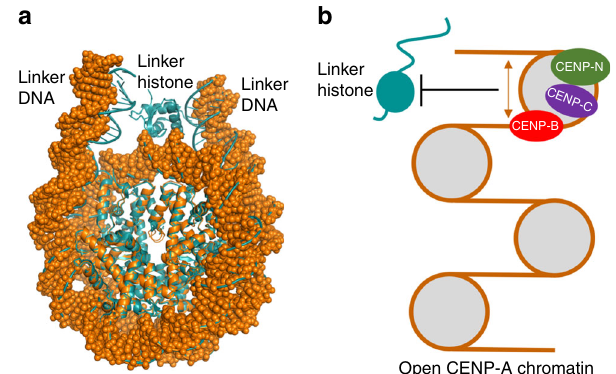
Fig. 5 Implications of the cryo-EM NCP CENP-A, NAS structure for the structure and function of centromeric chromatin. a A model of the CENP-A nucleosome (orange) with 10 bp linker DNA at each end, which is built by aligning a 10 bp DNA of a 20 bp B-DNA to the 10 bp DNA at each end of the DNA in NCP CENP-A, NAS . The CENP-A nucleosome was overlaid on the nucleosome bound to the globular domain of the linker histone H5 (cyan, PDB ID: 4QLC) by aligning the core histones. b Diagram illustration of the hypothesis that the active centromeric nucleosomes contain CENP-B box DNA sequence is likely to have more open DNA conformation (indicated by the arrow), which would prevent linker histones from binding to the CENP- A nucleosome stably and lead to less condensed chromatin structure that is more suitable for binding of kinetochore proteins CENP-C 12 , CENP-N 21,22 , and CENP-B